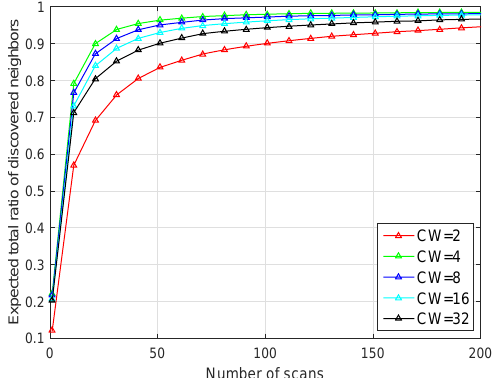
Figure 14. Performance of different values of the backoff